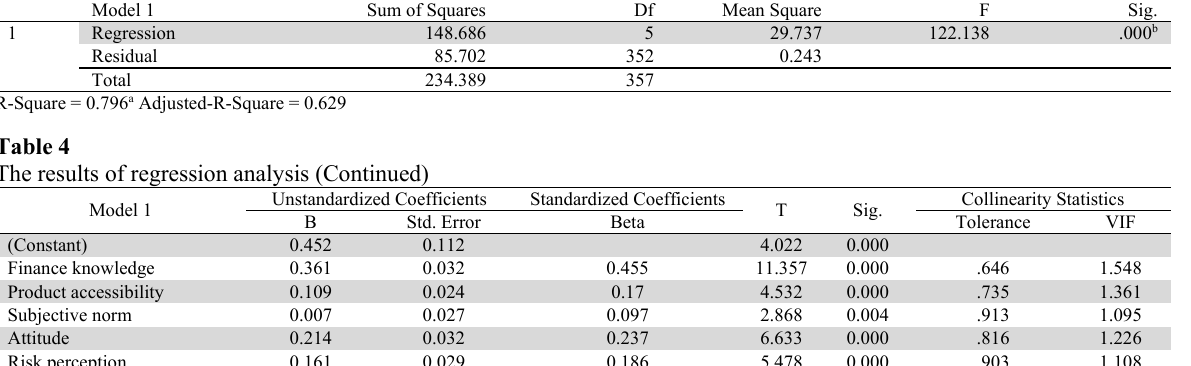
Model summary 1 ( Adjusted R Square, Anova)